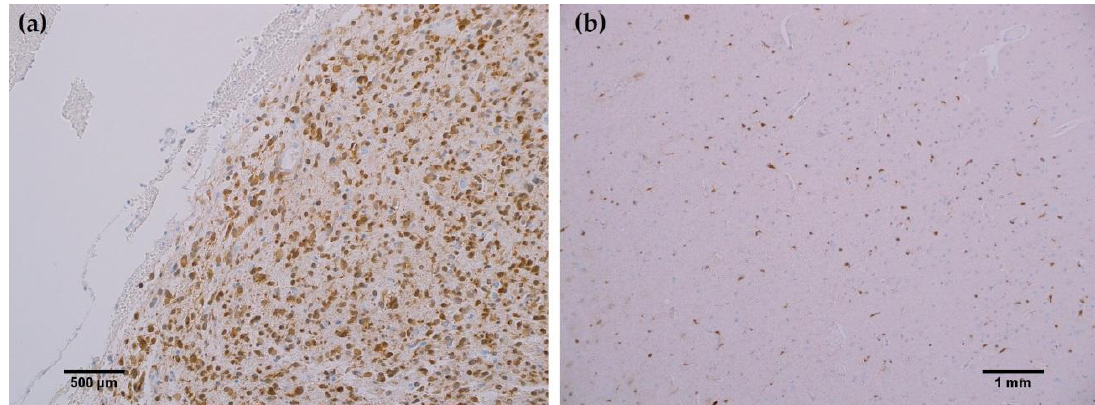
Figure 7. MRQ-67 immunohistochemistry (IHC) staining results in a primarily benign brain sample with a small tumor focus and some scattered tumor cells: ( a ) Cytoplasmic and weak nuclear labeling of cells within a small tumor focus of a benign brain sample (200×); ( b ) Scattered reactivity in single infiltrative tumor cells of the same benign brain case that have dispersed from the focal tumor site (100×).